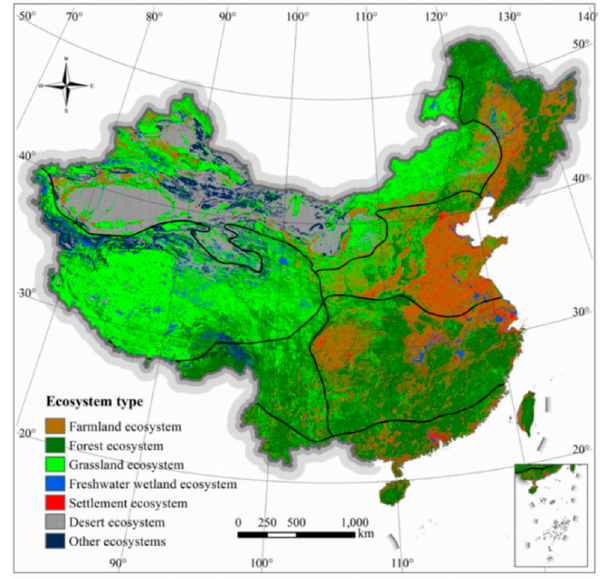
Figure 8. Spatial distribution of terrestrial ecosystems in China.